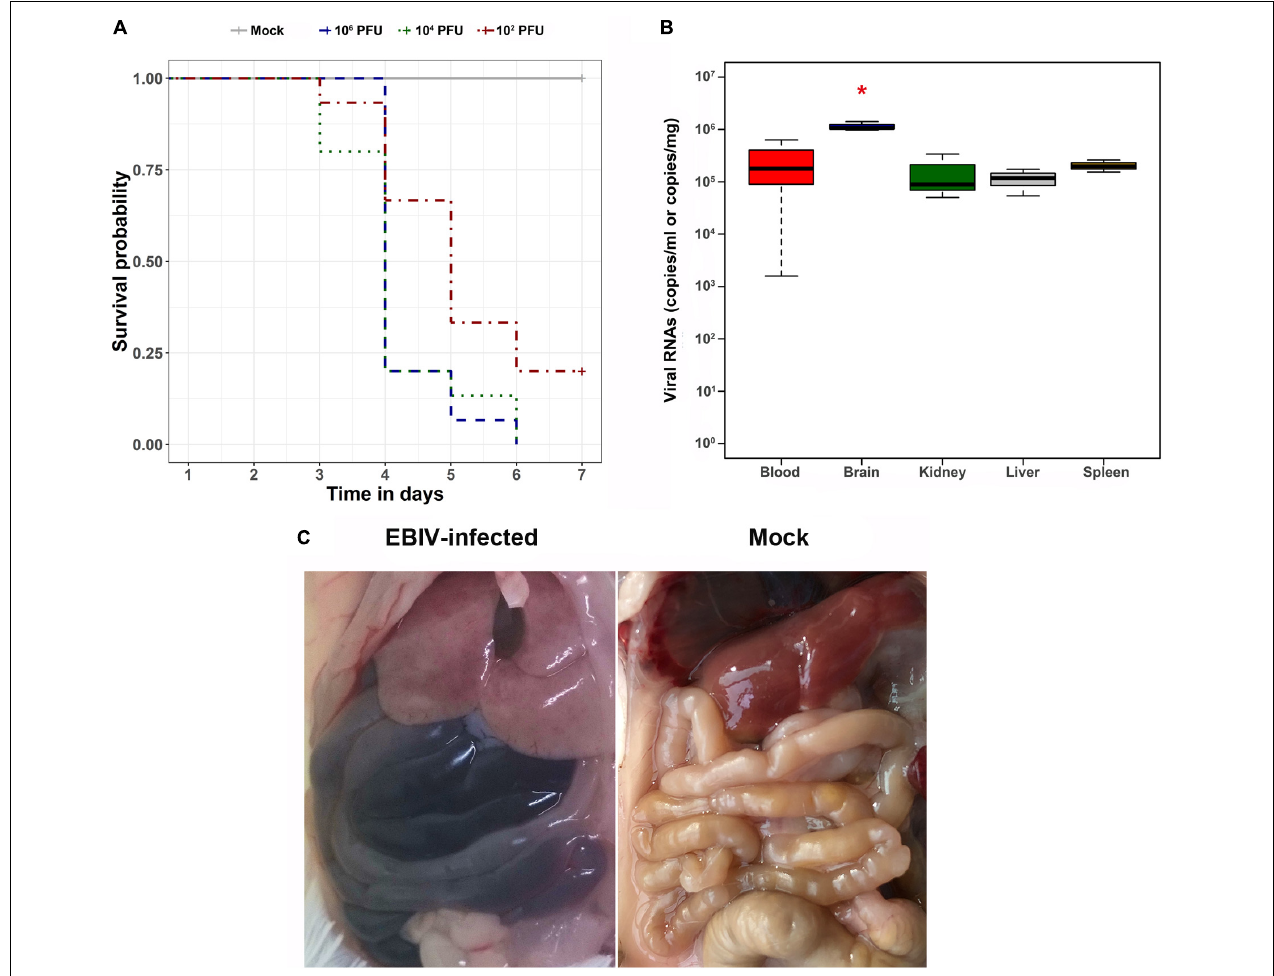
FIGURE 5 | Survival analysis, viral RNA detection in tissues, and gross pathology findings of EBIV-challenged mice. (A) Survival curve of mice challenged with serial dilutions of EBIV. Adult mice ( n = 5 per group, replicated three times) were challenged intraperitoneally with 10 6 PFU (dark blue), 10 4 PFU (dark green), and 10 2 PFU (dark red) of EBIV. (B) The viral RNA copies in blood, brain, kidney, liver, and spleen tissues were detected by quantitative RT-PCR, and the brain tissue presented a significant difference (* P < 0.05) compared to the other tested tissues. (C) In situ picture of organs in EBIV-infected animals with hemorrhaging and mock-infected